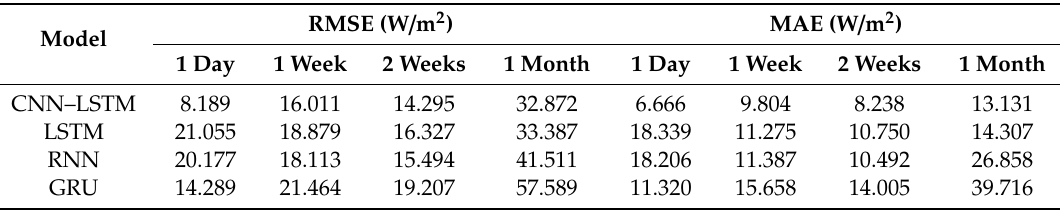
Table 7. Evaluation of predictive model (RMSE and MAE) over multiple forecast horizons.